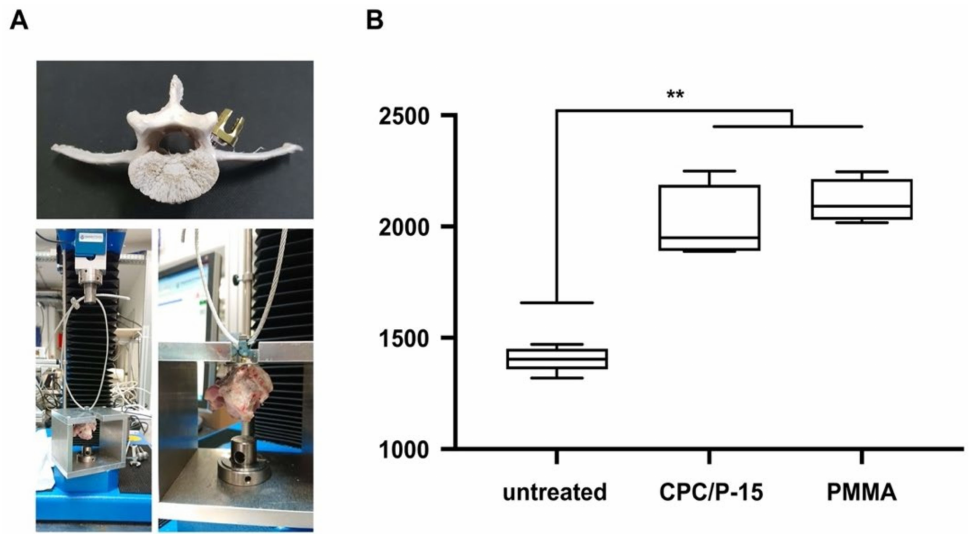
Figure 3. Axial pullout test and BMD in non-osteoporotic bone. ( A ) Pedicle screw placement in a skeletonized vertebra and set-up for pull-out testing. ( B ) F max in untreated vertebrae was 1405 ± 56 N, in those with PMMA, 2112 ± 98 N ( p < 0.0001), and 2010 ± 168 N ( p < 0.0001) when augmented with CPC/P-15. There was no statistically significant difference between PMMA and CPC/P-15 treatments ( p = 0.434). ** p <